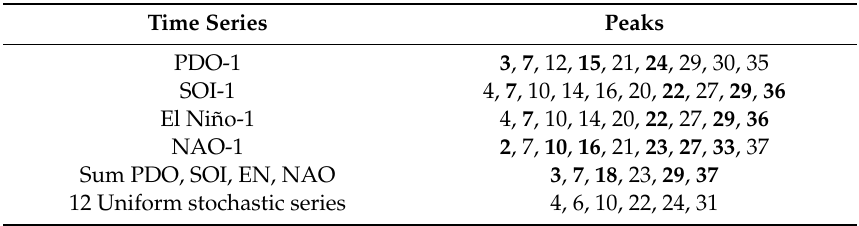
Table 1. Peaks in power spectral density curves. The full time series for the oscillations. “Sum” is all time series, including each of the sub periods before and after 1950. Numbers in bold designate peaks that visually higher than neighboring